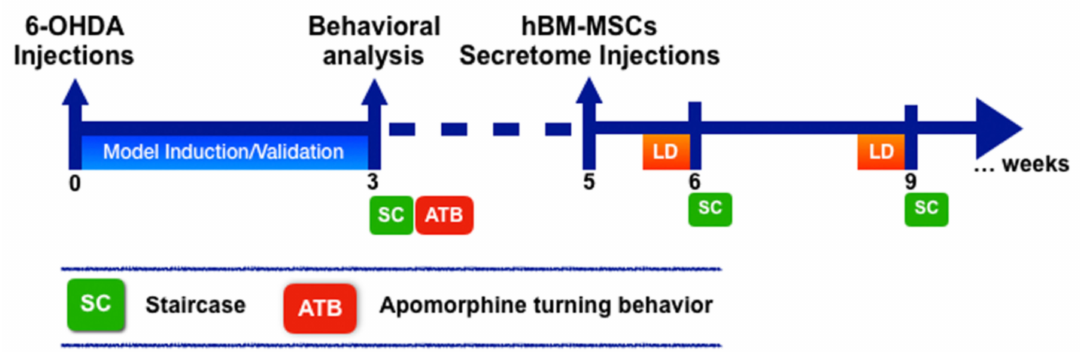
Figure 1. Experimental design. A unilateral 6-hydroxydopamine (6-OHDA) injection into the medial forebrain bundle (MFB) was performed to induce the rat Parkinson’s Disease (PD) model. Animal behavioral analysis through rotameter and staircase behavioral tests was performed to validate the model 3 weeks after 6-OHDA injections. Afterwards, human bone marrow mesenchymal stem cells (hBM-MSCs) secretome was (5 weeks after 6-OHDA injections) locally administrated into the substantia nigra (SN) and striatum (STR), respectively. Levodopa (LD), in turn, was given by oral gavage. 1 and 4 weeks after this treatment procedures, fine motor behavioral assessment (i.e., staircase) was